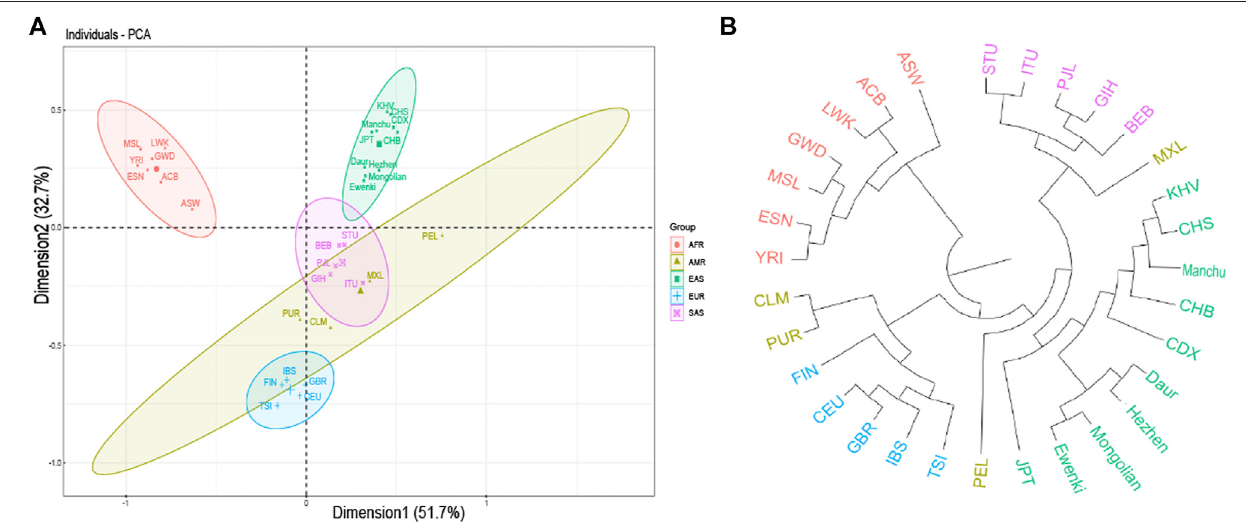
FIGURE 4 | PCA and Neighbor-joining tree results. (A) PCA based on the minimum allele frequency of the world populations. (B) Neighbor-joining tree based on geneticdistancefromtheworldpopulationgenotypedata.Note:CHB:HanChineseinBeijing; JPT:JapaneseinTokyo;CHS:SouthernHanChinese;CDX:ChineseDai inXishuangbanna;KHV:KinhinHoChiMinhCity,Vietnam;CEU:Utahresidents(CEPH)withNorthernandWesternEuropeanAncestry;TSI:ToscaniinItalia;FIN:Finnish inFinland;GBR:BritishinEnglandandScotland;IBS:IberianPopulationinSpain;YRI:YorubainIbadan,Nigeria;LWK:LuhyainWebuye,Kenya;GWD:Gambianin WesternDivisionsintheGambia;MSL:MendeinSierraLeone;ESN:EsaninNigeria;ASW:AmericansofAfricanAncestryinSWUnitedStates;ACB:AfricanCaribbeans in Barbados;MXL: Mexican Ancestry from Los Angeles United States; PUR: Puerto ricans from Puerto rico;CLM: Colombians from Medellin,Colombia; PEL: Peruvians from Lima, Peru; GIH: Gujarati Indian from Houston, Texas; PJL: Punjabi from Lahore, Pakistan; BEB: Bengali from Bangladesh; STU: Sri Lankan Tamil from the United Kingdom; ITU: Indian Telugu from the United